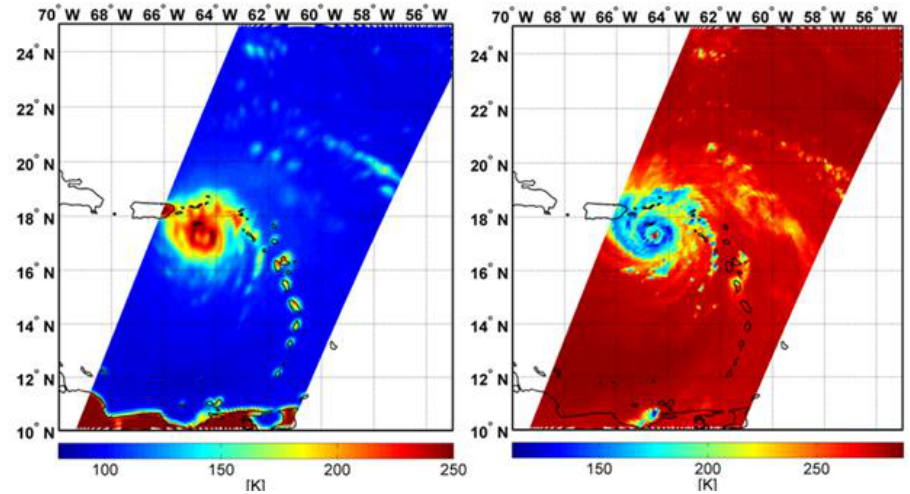
Figure 1. Hurricane Maria southeast of Puerto Rico, on 20 September 2017 at 02:03 UTC. TB (K) at 10.7 H-pol GHz ( left panel ) at 166.0 V-pol GHz ( right panel ) from GMI overpass.